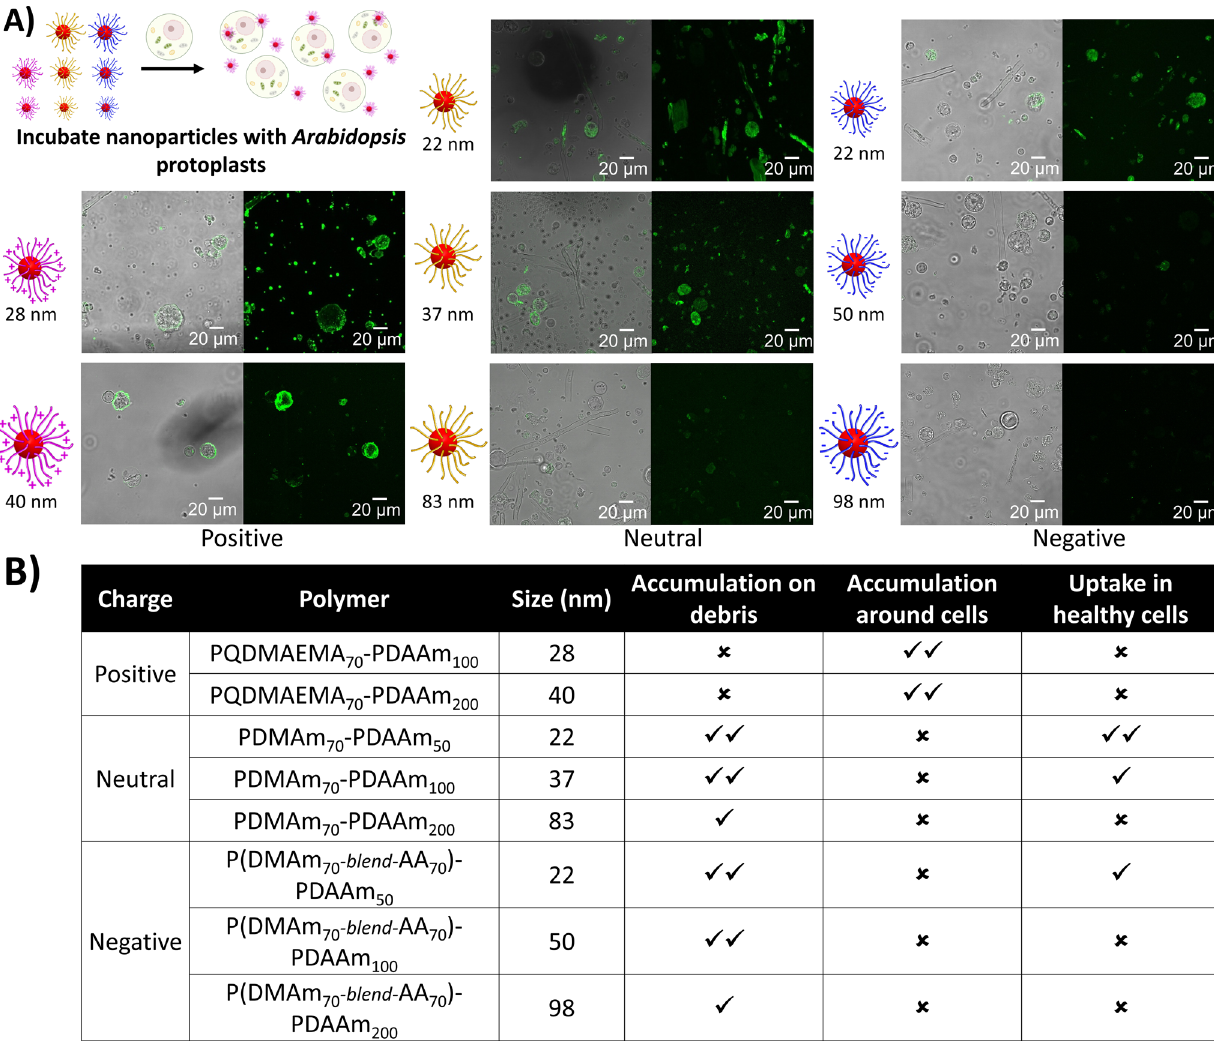
using ImageJ software. Scale bar=20 μ m. The images are representatives of experimental replicates ( n =3). It was noted that the smallest positively charged nanoparticles appeared to have a cytotoxic effect with an increase in visible